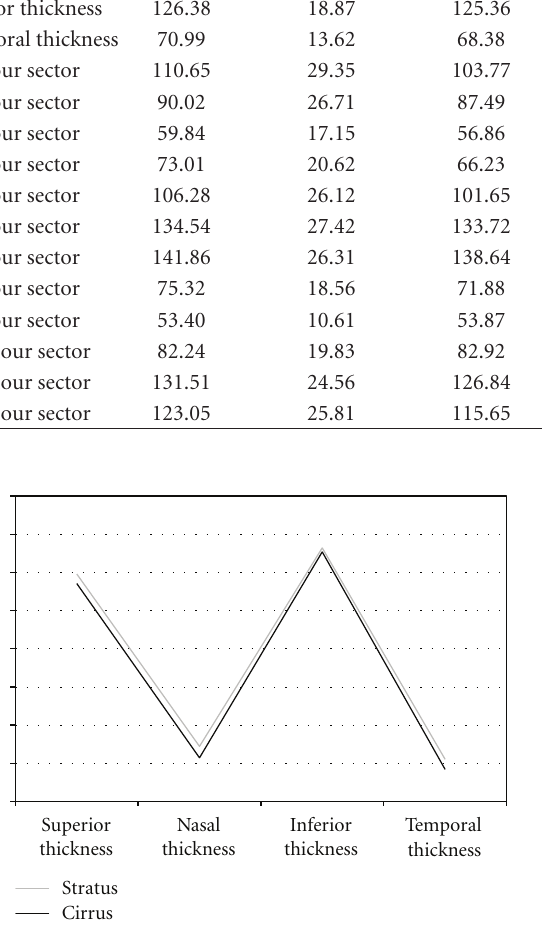
Figure 1: Representation for retinal nerve fiber layer thicknesses in the four quadrants using Cirrus HD and Stratus OCT devices. Measurements were higher with Cirrus OCT.